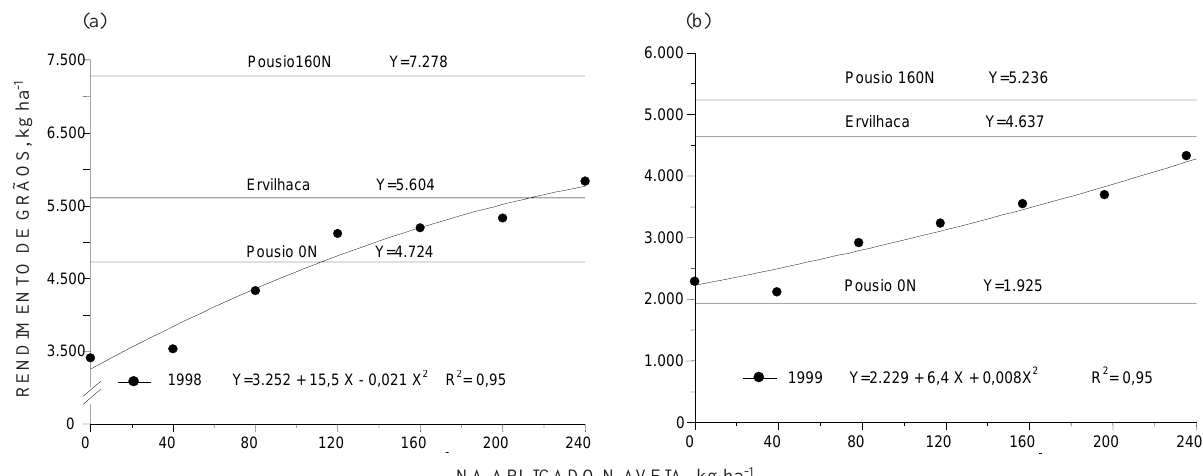
Figura 6. Rendimento de grãos de milho de acordo com o N aplicado na aveia preta, nos anos de 1998 (a) e 1999 (b).